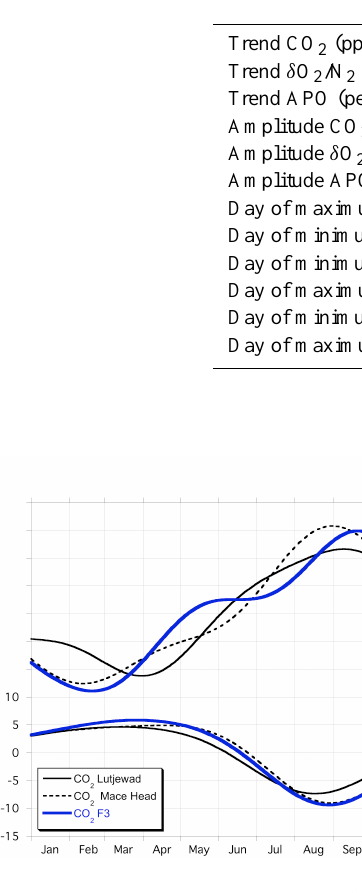
Fig. 5. The de-trended seasonal patterns of CO 2 and O 2 at station Figure 5 : The de-trended seasonal patterns of CO 2 and O 2 at station Lutjewad (black solid line), Mace Head (black dashed line) and F3 (blue solid line) during 2000-2009, Lutjewad (black solid line), Mace Head (black dashed line) and F3 based on flask measurements (and continuous measurements for F3). (blue solid line) during 1998–2009, based on flask measurements (and continuous measurements for